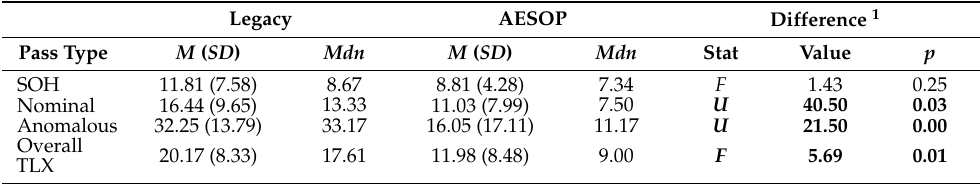
Table 4. Descriptive Statistics and Means Testing for Workload on All HMIs and Pass Types.